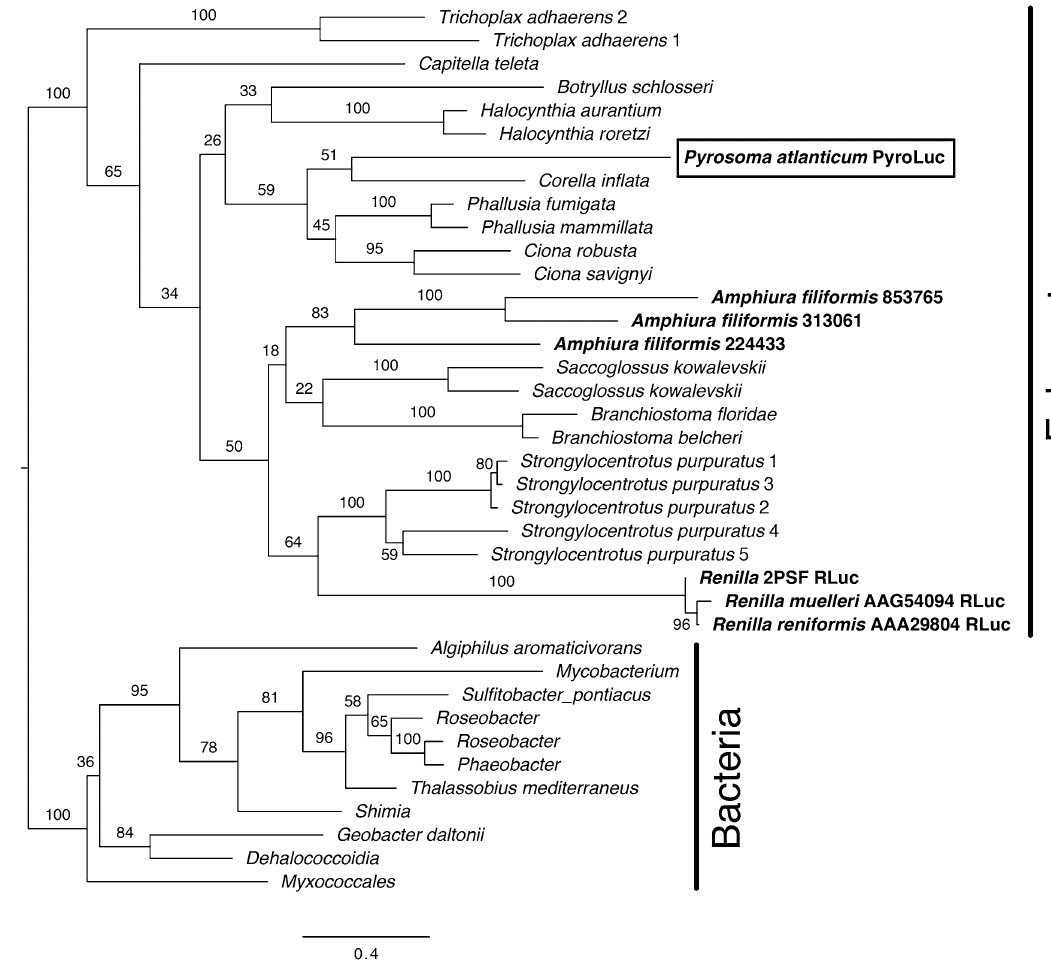
Figure 4. Maximum likelihood phylogeny of RLuc-like luciferases (bolded) and haloalkane dehalogenases. PyroLuc from Pyrosoma atlanticum is accentuated with a box. Support values are summaries of 1000 bootstrap replicates. The luciferases from A. filiformis have yet to be functionally confirmed, but are highly probable 29